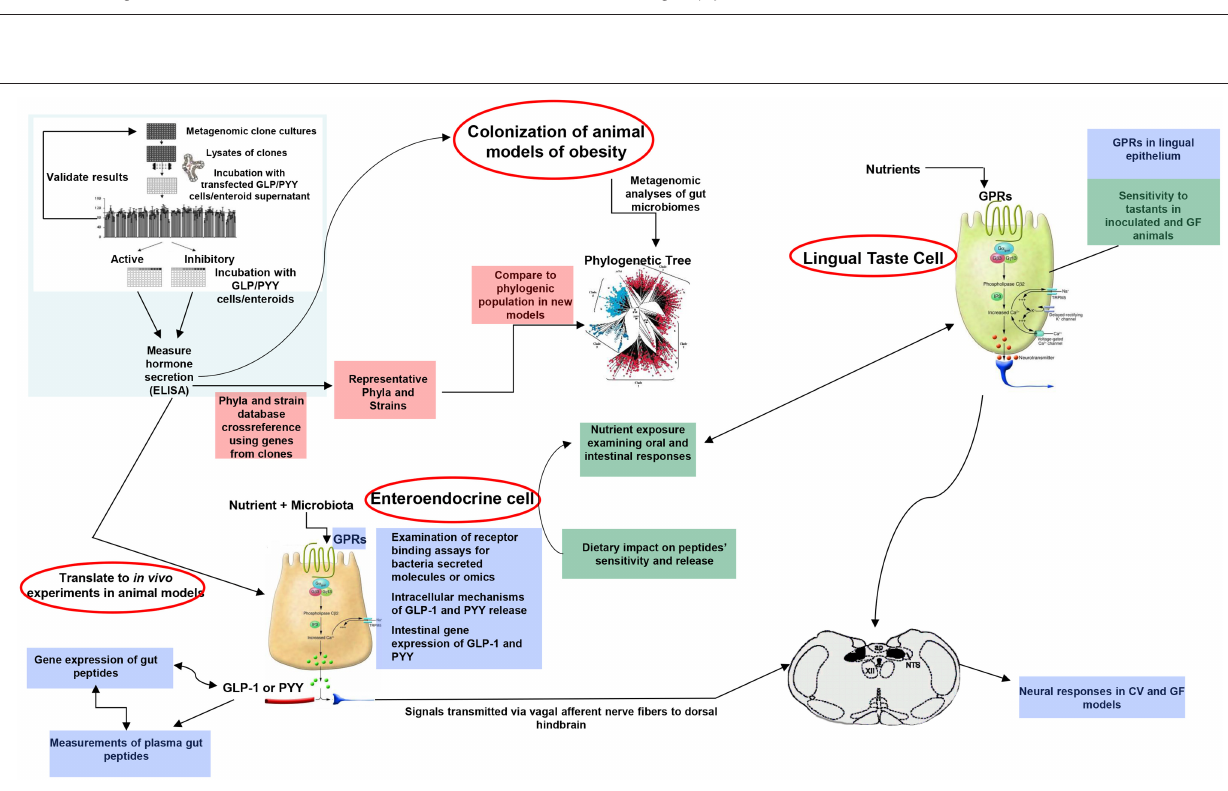
Frontiers in Endocrinology |